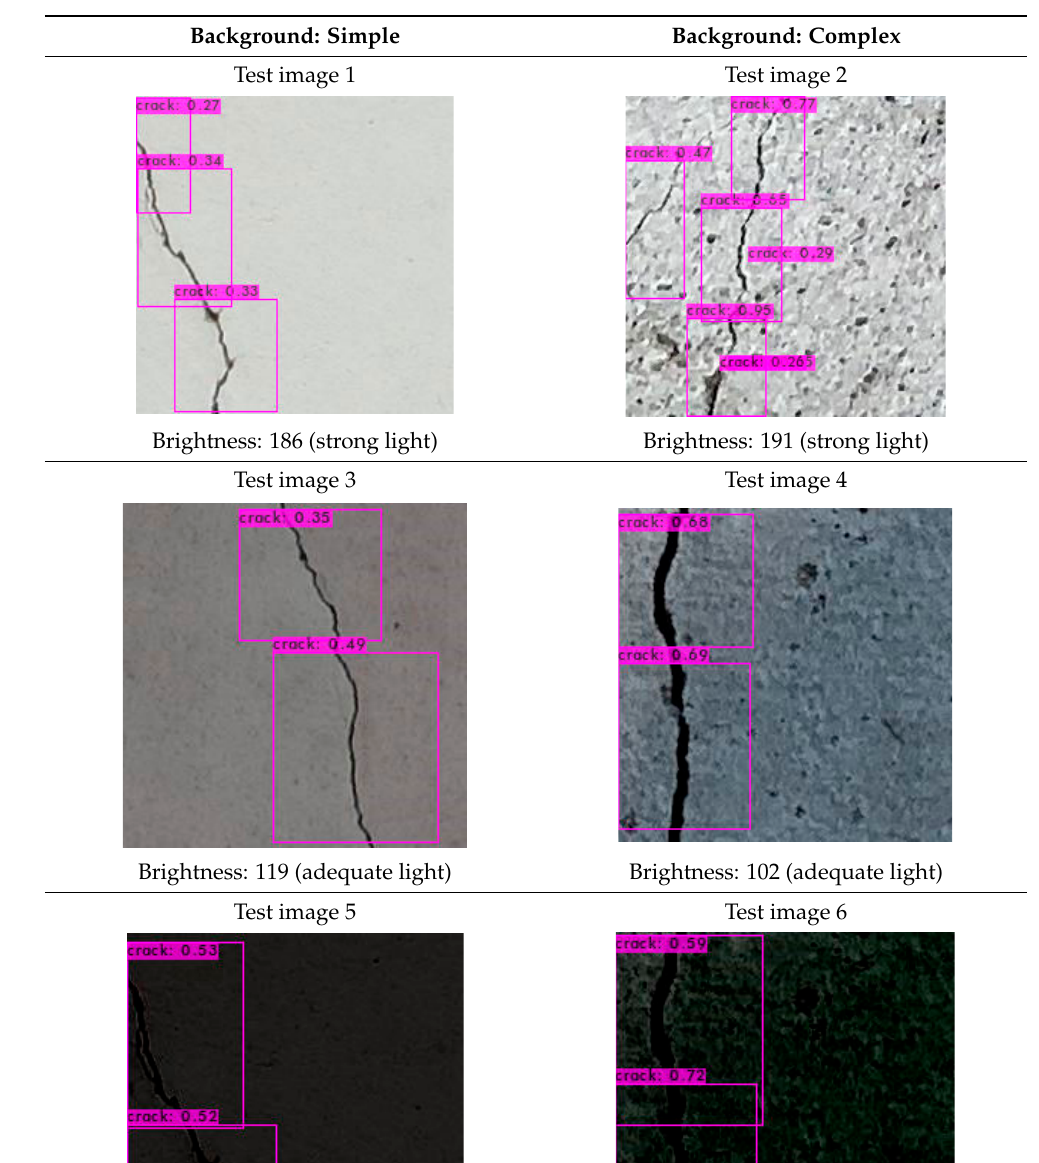
Table 5. Crack identification outcomes for different lighting and backgrounds. Background: Simple Background: